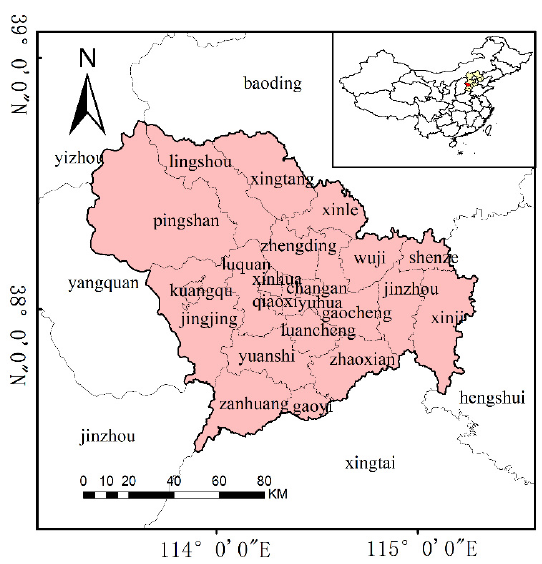
Figure 1. Geographical location and administrative division of the study area.